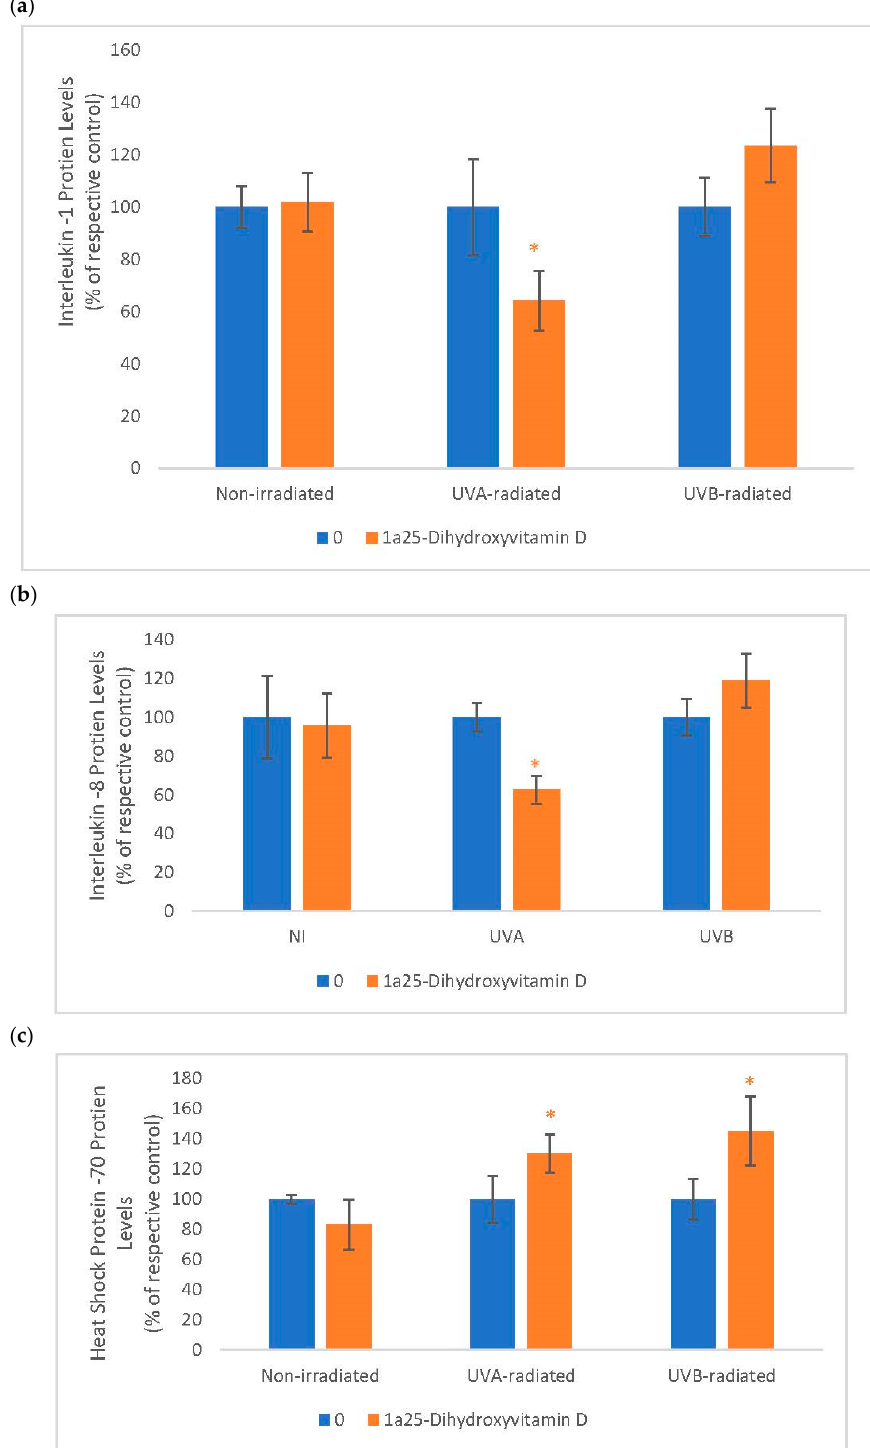
Figure 6. The effect of 1 α , 25dihydroxyvitamin D3 (vitamin D) on interleukin-1 (IL-1), interleukin-8 (IL-8) and heat shock protein-70 (HSP-70) in non-irradiated, UVA-radiated, and UVB-radiated fibroblasts. Non-irradiated, UVA-radiated, or UVB-radiated fibroblasts were incubated with vitamin D (0 or 2 µ M) for 24 h, and examined for IL-1 ( a ), IL-8 ( b ), and HSP-70 ( c ) protein levels by indirect ELISA (Kirkguaard and Perry Inc). * = p < 0.05, relative to respective controls. Error bars represent standard deviation, n =